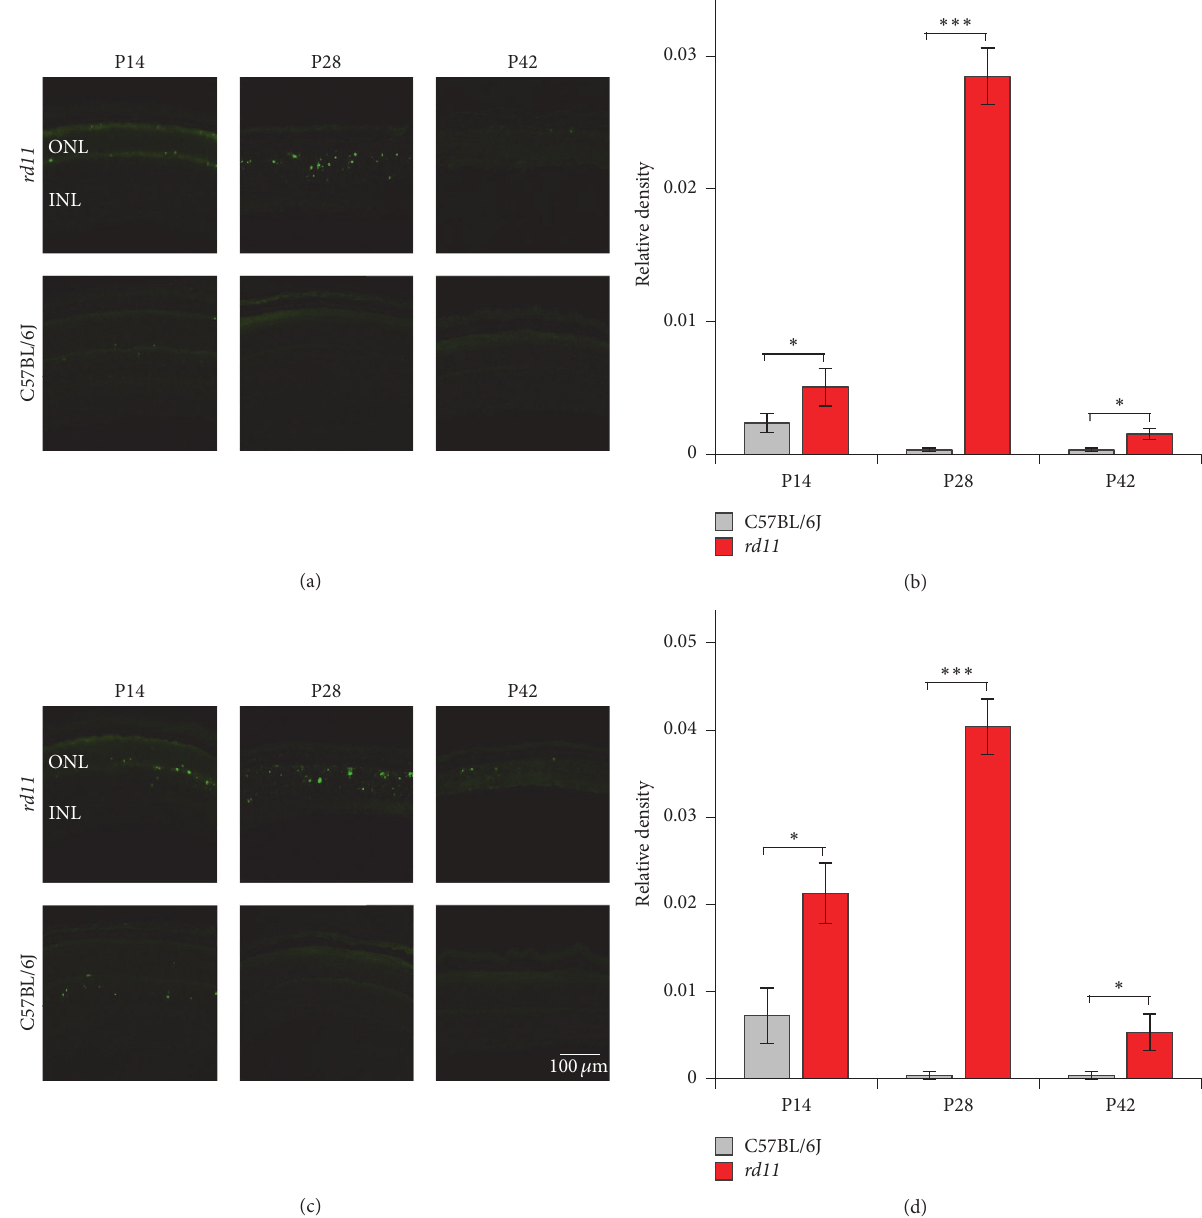
Figure 5: TUNEL staining in C57BL/6J control and rd11 retina. (a) and (c) Central (a) and peripheral (c) retina from P14, P28, and P42 C57BL/6J and rd11 mice. (b) and (d) The quantification of positive signals from (a) and (c). ONL: outer nuclear layer; INL: inner nuclear layer. ∗ 𝑝 < 0.05 ; ∗∗∗ 𝑃 < 0.001 . 𝑛 = 5 retina per